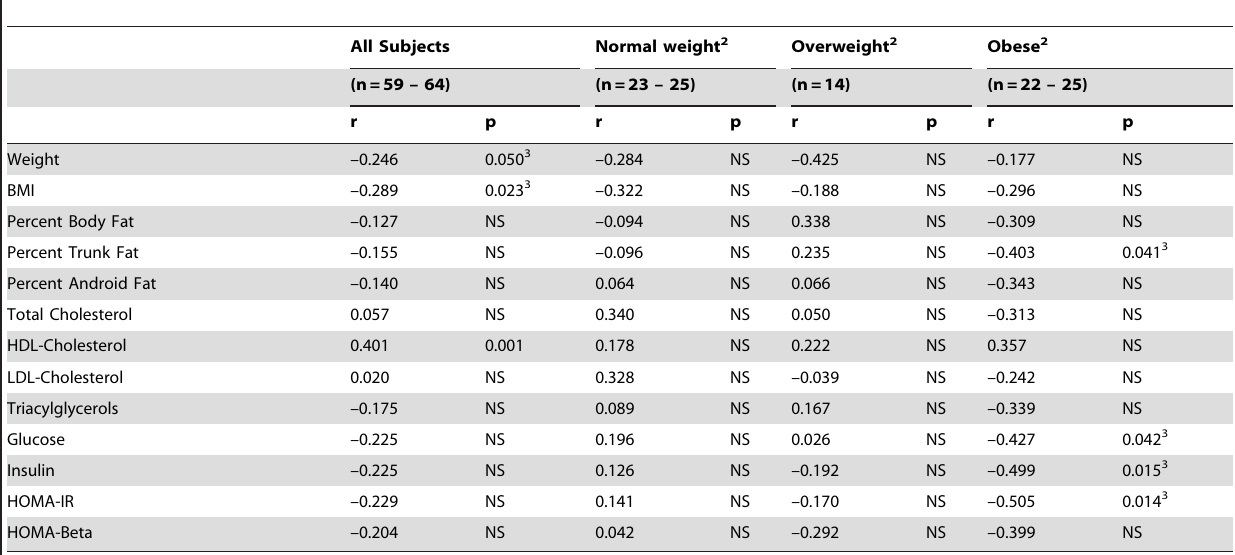
Table 2. Partial correlations of baseline variables related to baseline fasting serum adiponectin, after control for age 1